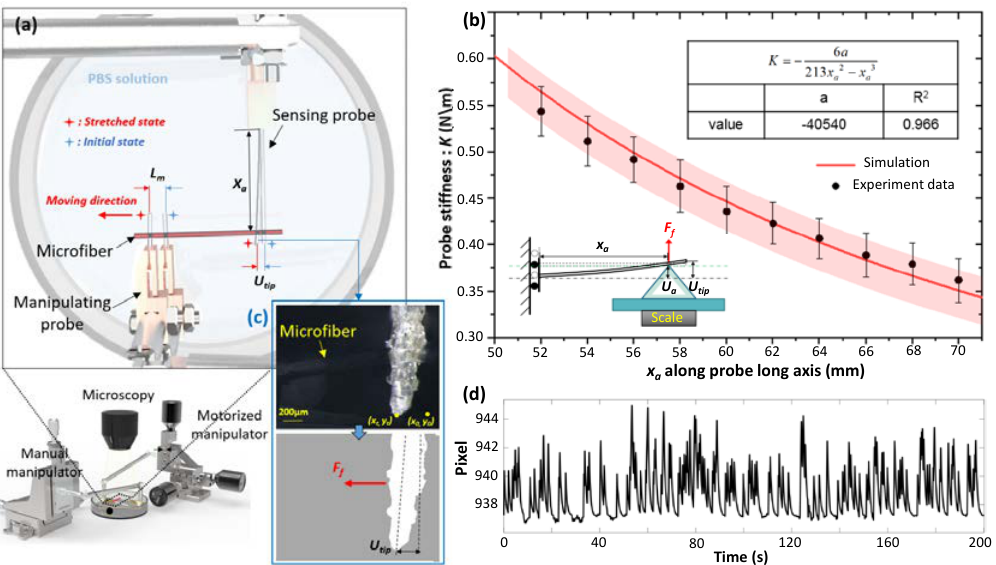
Figure 2. Measuring accuracy analysis of the sensing tube-indicated stretching force. ( a ) Schematic of two − tube stretching manipulation. ( b ) Calibration of the stiffness: K of the sensing tube. ( c ) Process of the sensing tube’s tip recognition to measure the u tip . ( d ) Pixel fluctuation process of the tip.